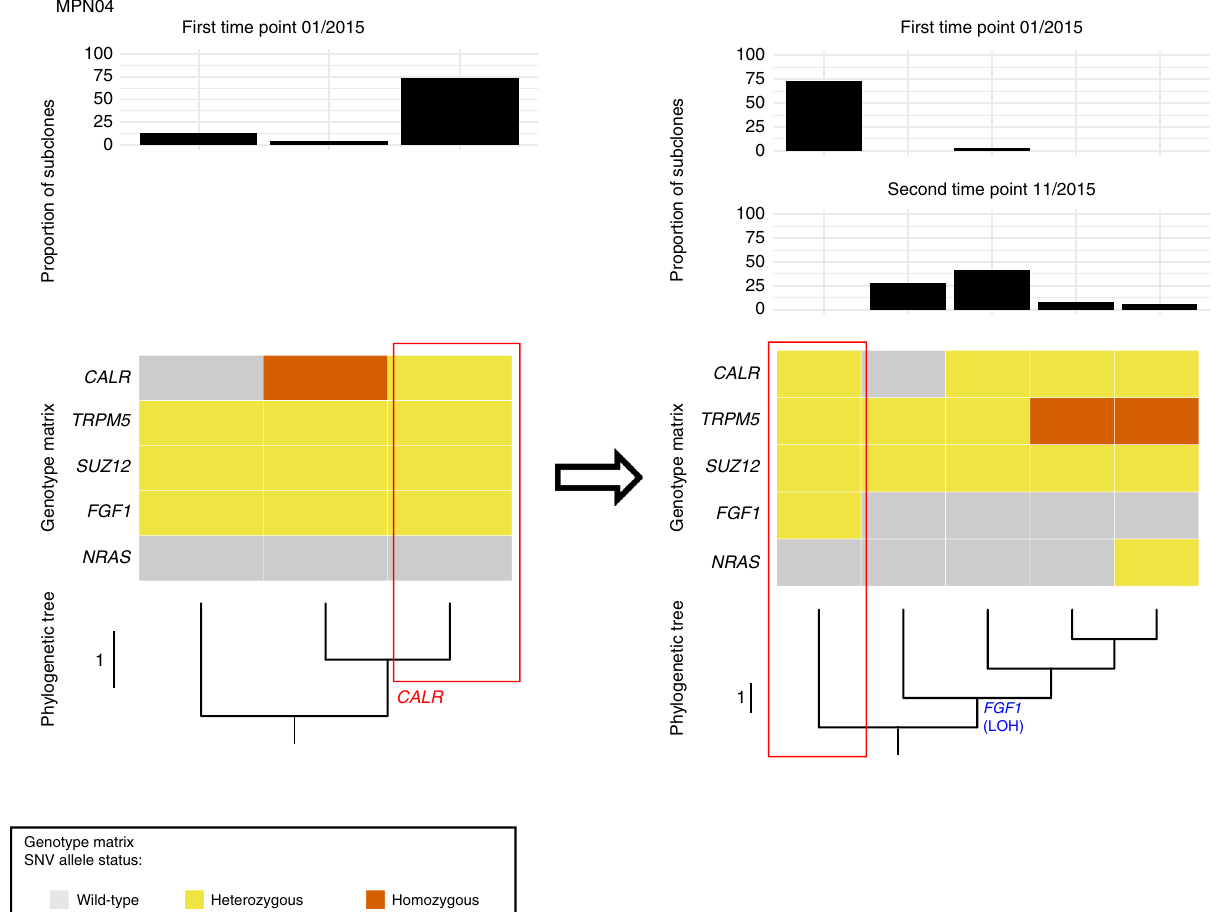
Fig. 5 Phylogenetic Tree of CD34 + progenitors and proportion of clones in MPN04. MPN04 showed a complete change in clonal architecture due to an acquired LOH of FGF1 V66M on chromosome 5q31 between the two investigated time points (before and after leukemic transformation). At fi rst time point, a dominant clone harboring mutations in CALR, FGF1, SUZ12 , and TRPM5 was present, from which a subclone acquired a del(5)(q23-q32), leading to wild-type FGF1 . At the second time point, this subclone developed additional genetic abnormalities affecting CALR and TRPM5 . Top panel: bar chart displaying the proportion of each observed subclone. Middle panel: genotype matrix for each subclone. Bottom panel: Evolutionary trees generated by analysis of the single-cell data. A single-phylogenetic tree was constructed and displayed as a vertically oriented rectangular cladogram. The root of the tree harbors a wild-type cell genotype. Branch lengths are indicated (proportional to the number of evolutionary changes inferred) and the internal nodes (the points at which branches diverge) represent the ancestral clade from which arise all genotypes at the leaves/ tips of the tree (descendant subclones). Source data are provided as a Source Data fi